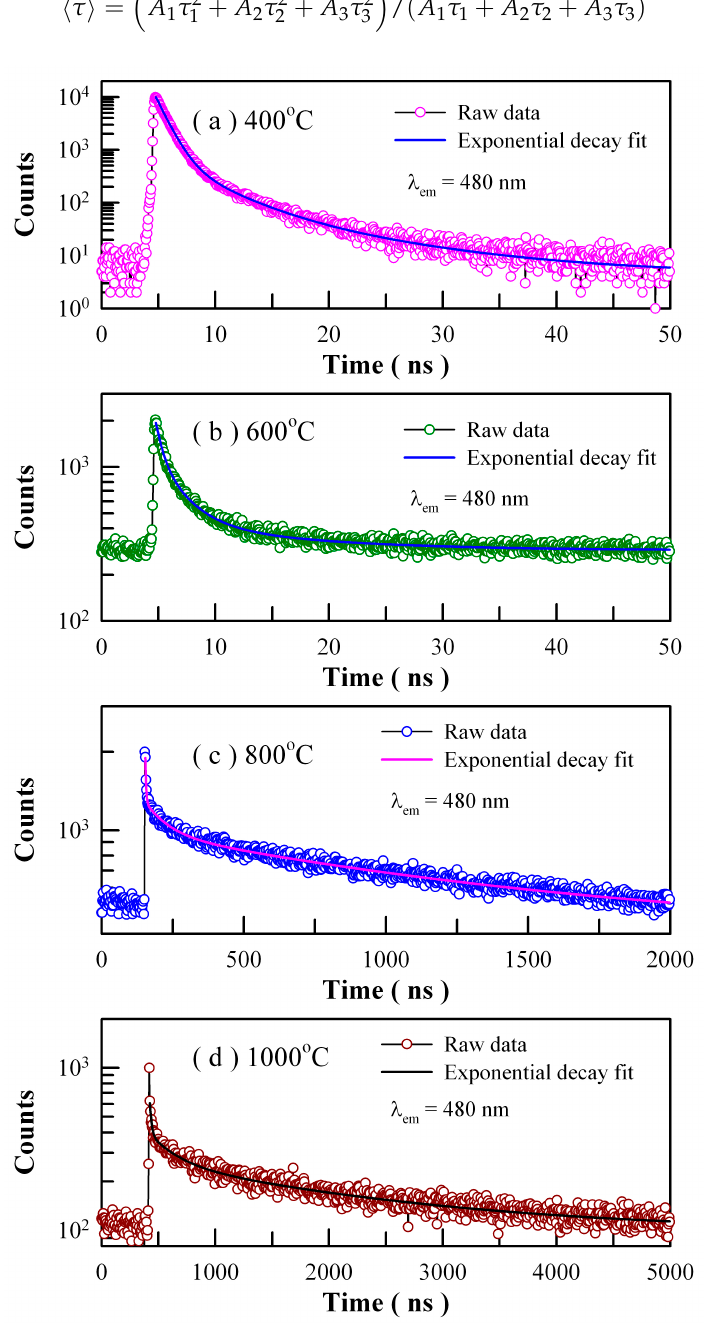
Figure 18. Time-resolved PL spectra of Eu-doped ZnWO 4 precursors subjected to annealing at different temperatures: ( a ) 400 ◦ C; ( b ) 600 ◦ C; ( c ) 800 ◦ C; and ( d ) 1000 ◦ C. The detection wavelength is fixed at 480 nm. The repetition frequencies of the pulsed diode laser are 20 MHz, 20 MHz, 500 kHz and 200 kHz, respectively.